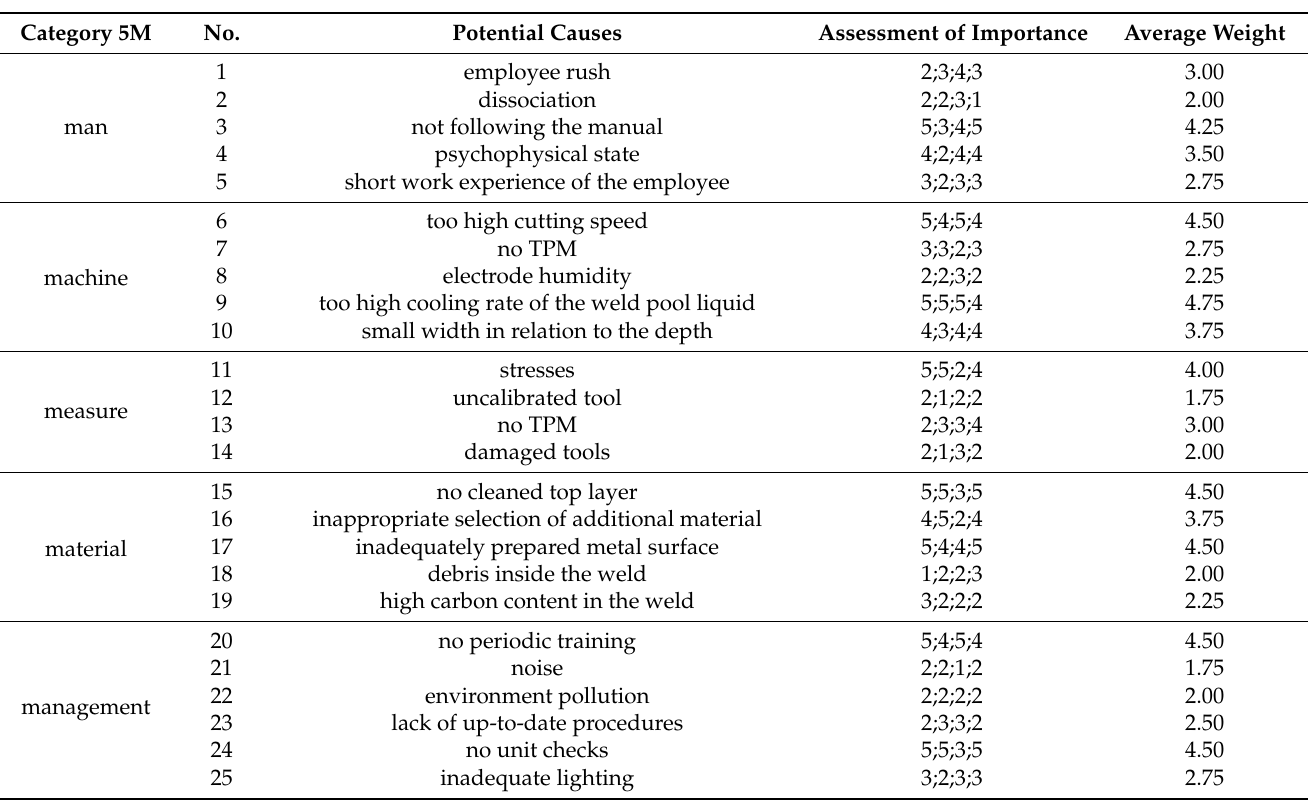
Table 2. Average weights of potential